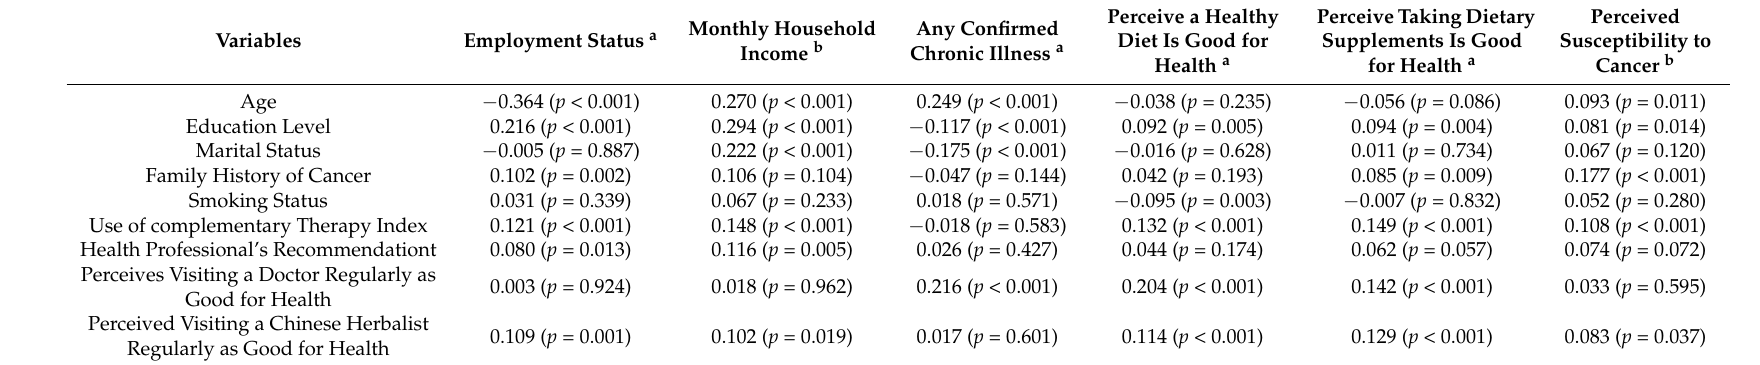
Table 5. Associations between the retained variables in the multivariable logistic regression and those that showed significance in univariate but not in multivariable